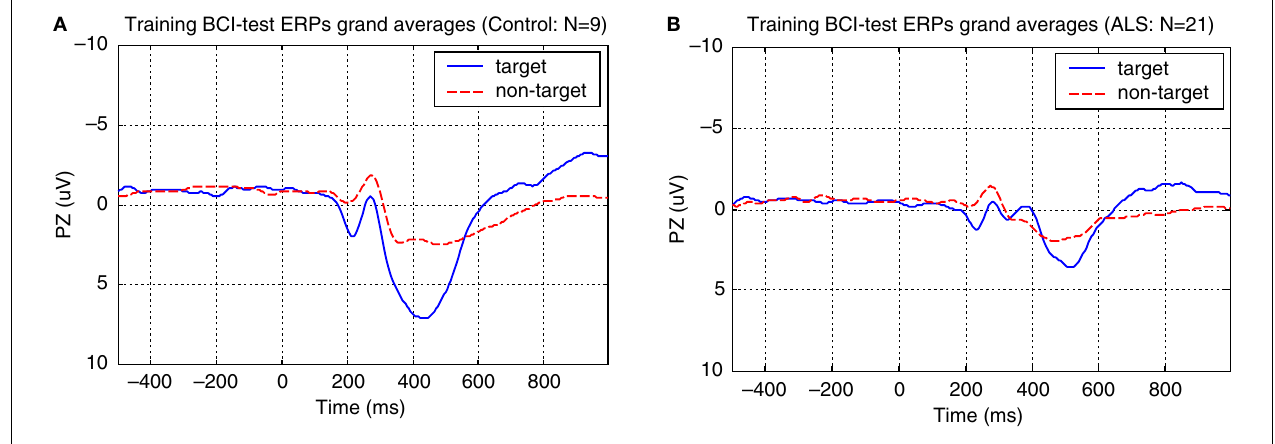
FIGURE 3 | Training BCI-test ERPs grand averages. (A) Control, (B) ALS. Mean ± SD number of target stimuli: 181 ± 54 (non-target stimuli: 541 ±